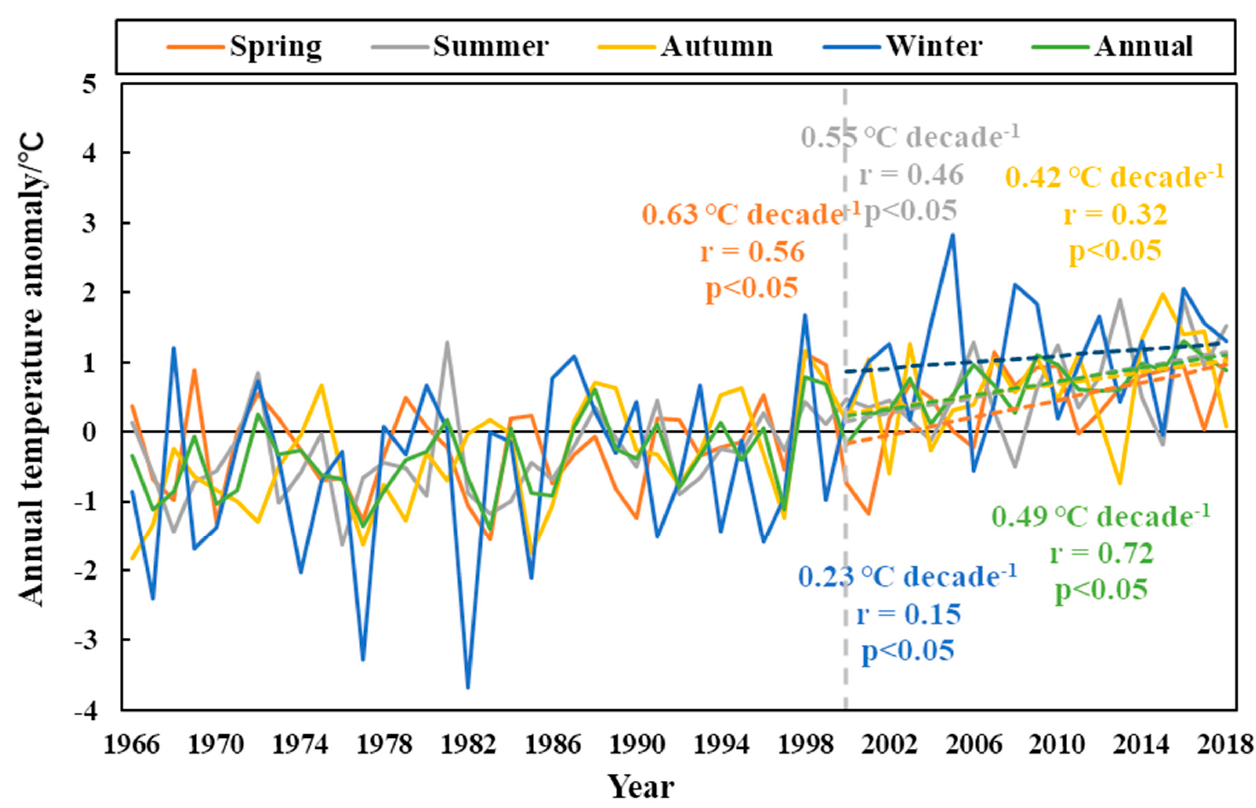
Figure 2. Time series of the spring, summer, autumn, winter, and annual mean air temperature anomalies from 1966 to 2018.